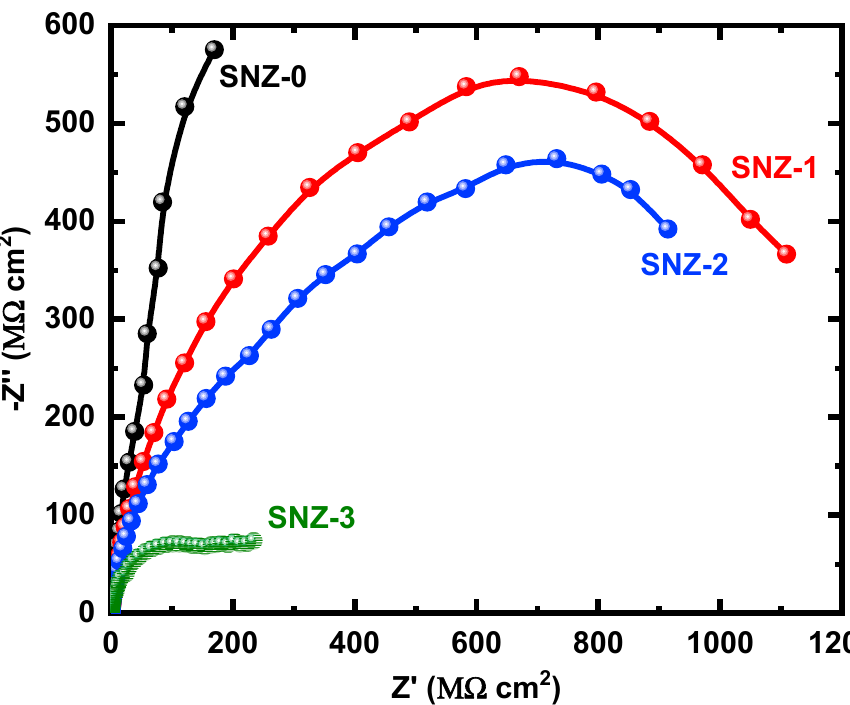
Figure 4. Nyquist plots of the coatings after 1 h immersion in a 3.5% NaCl solution.